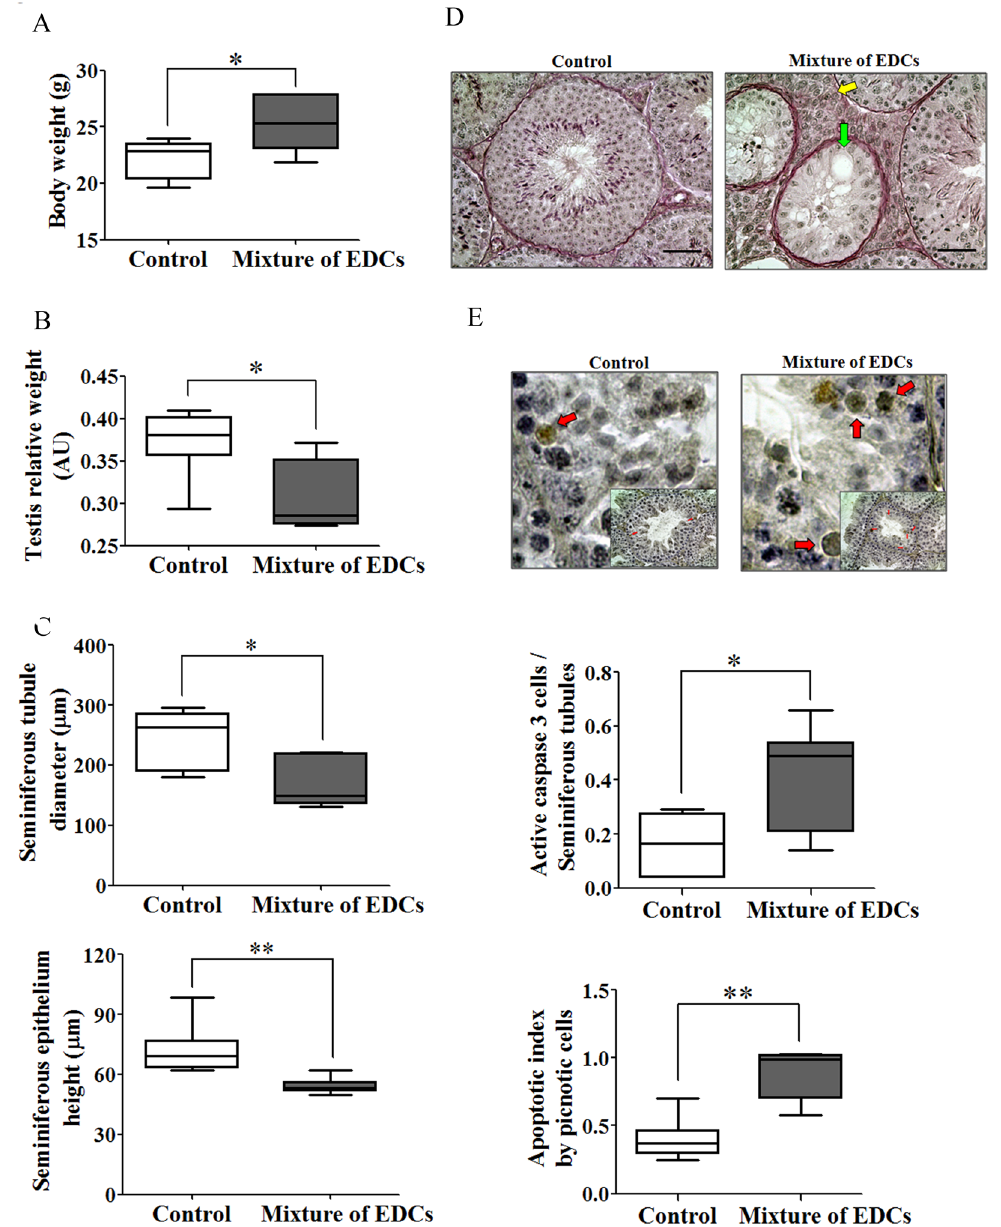
Figure 2. Testes injury and germ cell apoptosis in mice exposed to the mixture of EDCs. ( A ) Mouse body weight. ( B ) Relative weight of testis. ( C ) Morphometric analysis of seminiferous tubules (diameter and epithelium height). ( D ) Representative picture of PAS/hematoxylin staining of seminiferous tubules, yellow arrow shows Leydig cell lesion (hypertrophic/hyperplastic) and green arrow shows seminiferous tubule degeneration. ( E ) Representative pictures of caspase-3 positive germ cells (red arrow) in seminiferous tubules and quantification of the number of caspase-3 positive germ cells and pyknotic cells. All graphics represent the mean ± SEM. For A-B) control group n = 9, EDCs mixture exposed group n = 6. Abbreviation: AU, arbitrary units. ( C ) Control and EDCs mixture exposed group n = 6, Mann–Whitney U test, * p < 0.05; ** p < 0.01. ( D–E ) Control group n = 4, EDCs mixture exposed group n = 3 (100 seminiferous tubules), Mann–Whitney U test, * p < 0.05, ** p <